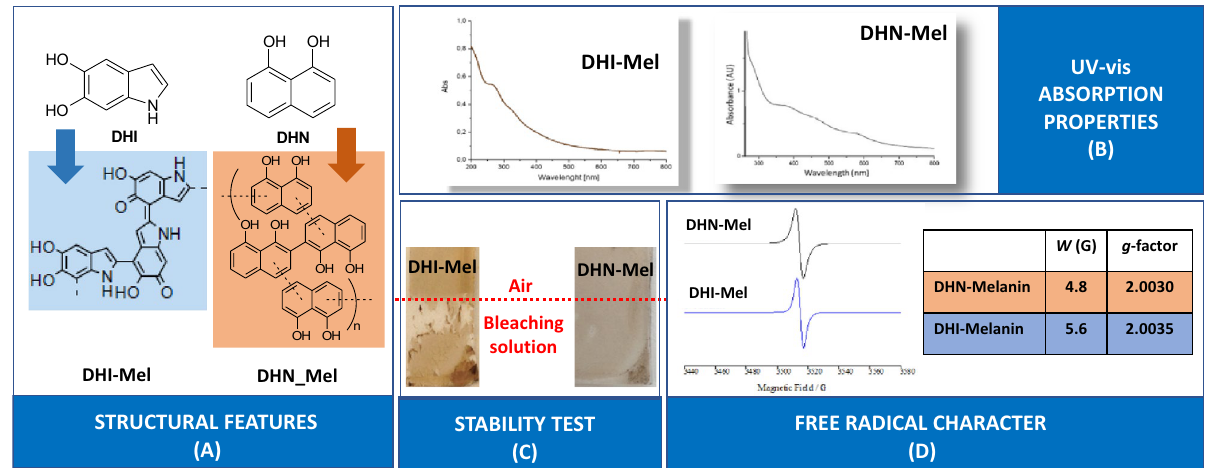
Figure 1. Pictorial view of the main properties of the melanin polymers obtained from DHI and DHN. In detail, ( A ) shows the main structural features, ( B ) shows the UV–visible absorption profiles, ( C ) shows the different robustness and ( D ) shows the EPR spectra and main data 58–62